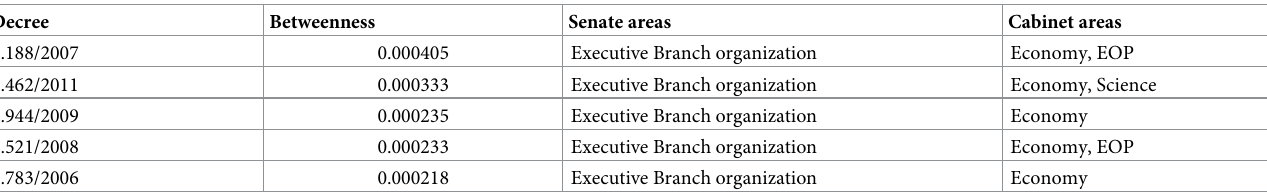
Table 11. Top 5 decrees according to betweenness